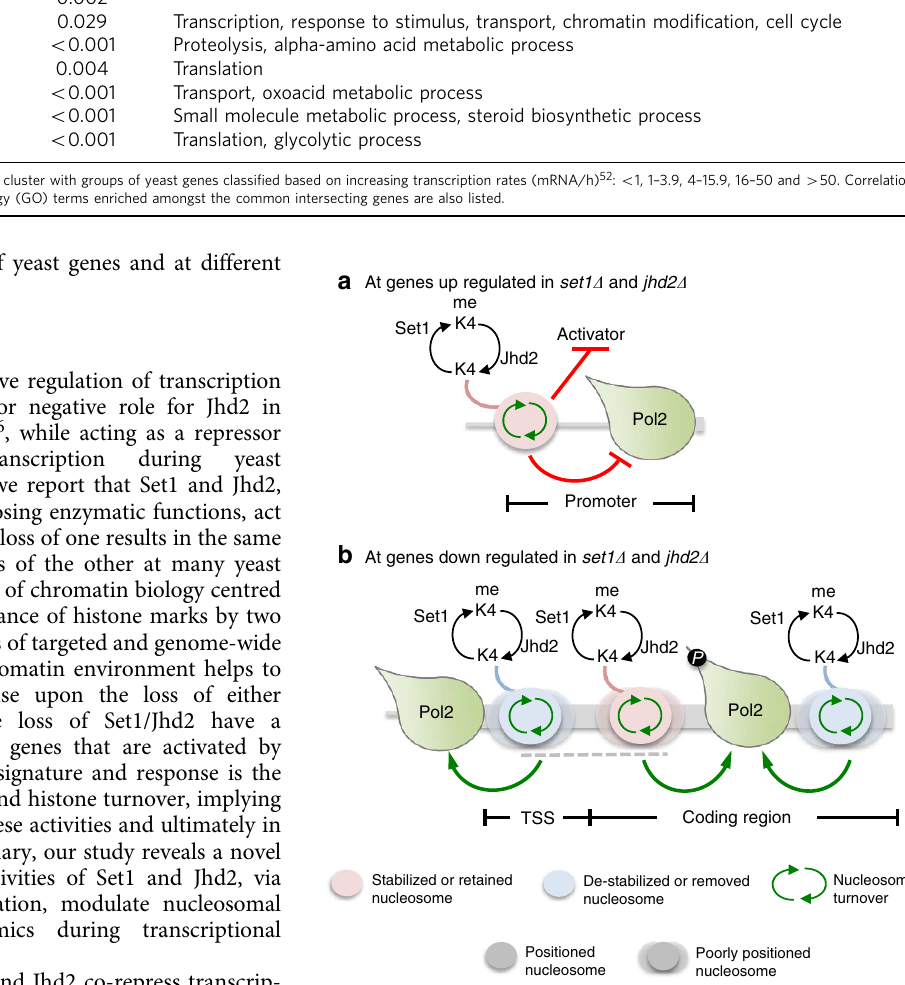
Figure 7 | Model for Set1 and Jhd2-mediated co-regulation of chromatin structure and RNA Pol2 functions. ( a ) Target genes co-repressed by Set1 and Jhd2 are packaged into a well-defined chromatin organization. At these genes, Set1 and Jhd2 activities via H3K4 methylation–demethylation impact histone turnover at promoters leading to nucleosome retention, which restricts activator and/or RNA Pol2 binding. Thus, Set1 and Jhd2 are proposed to primarily co-regulate transcription initiation at these target genes. ( b ) Target genes co-activated by Set1 and Jhd2 are present in a poorly organized chromatin configuration, contain high levels of H3K4me2 and undergo high nucleosomal turnover over coding region. Set1 and Jhd2 activities via modulating H3K4 methylation levels impact nucleosomal turnover over coding regions, and proposed to remove þ 1 nucleosomes in front of RNA Pol2 and stabilize or retain nucleosomes behind the elongating RNA Pol2. Thus, Set1 and Jhd2 are proposed to co-regulate transcription elongation at these target genes. P , phosphorylated form of RNA Pol2 engaged in